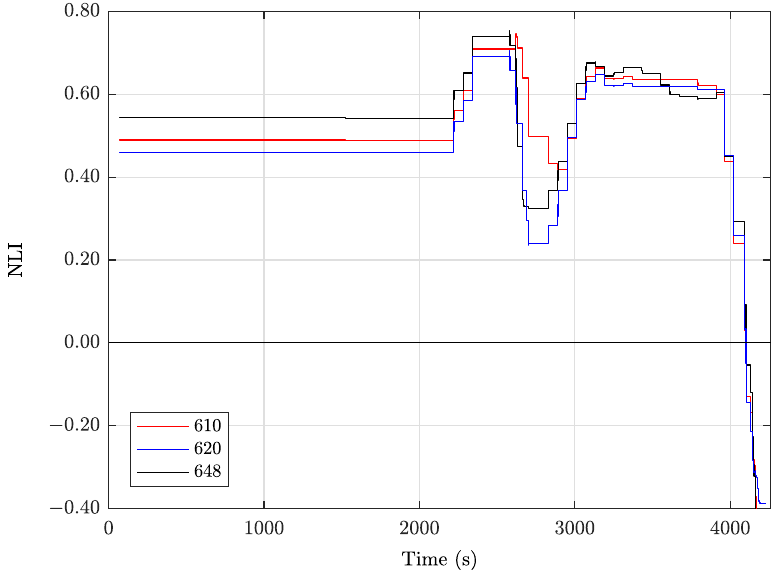
Figure 7. NLI response at EHV buses 610 (Acharnon), 620 (Koumoundourou) and 648 (Ag. Stefanos), unstable scenario.